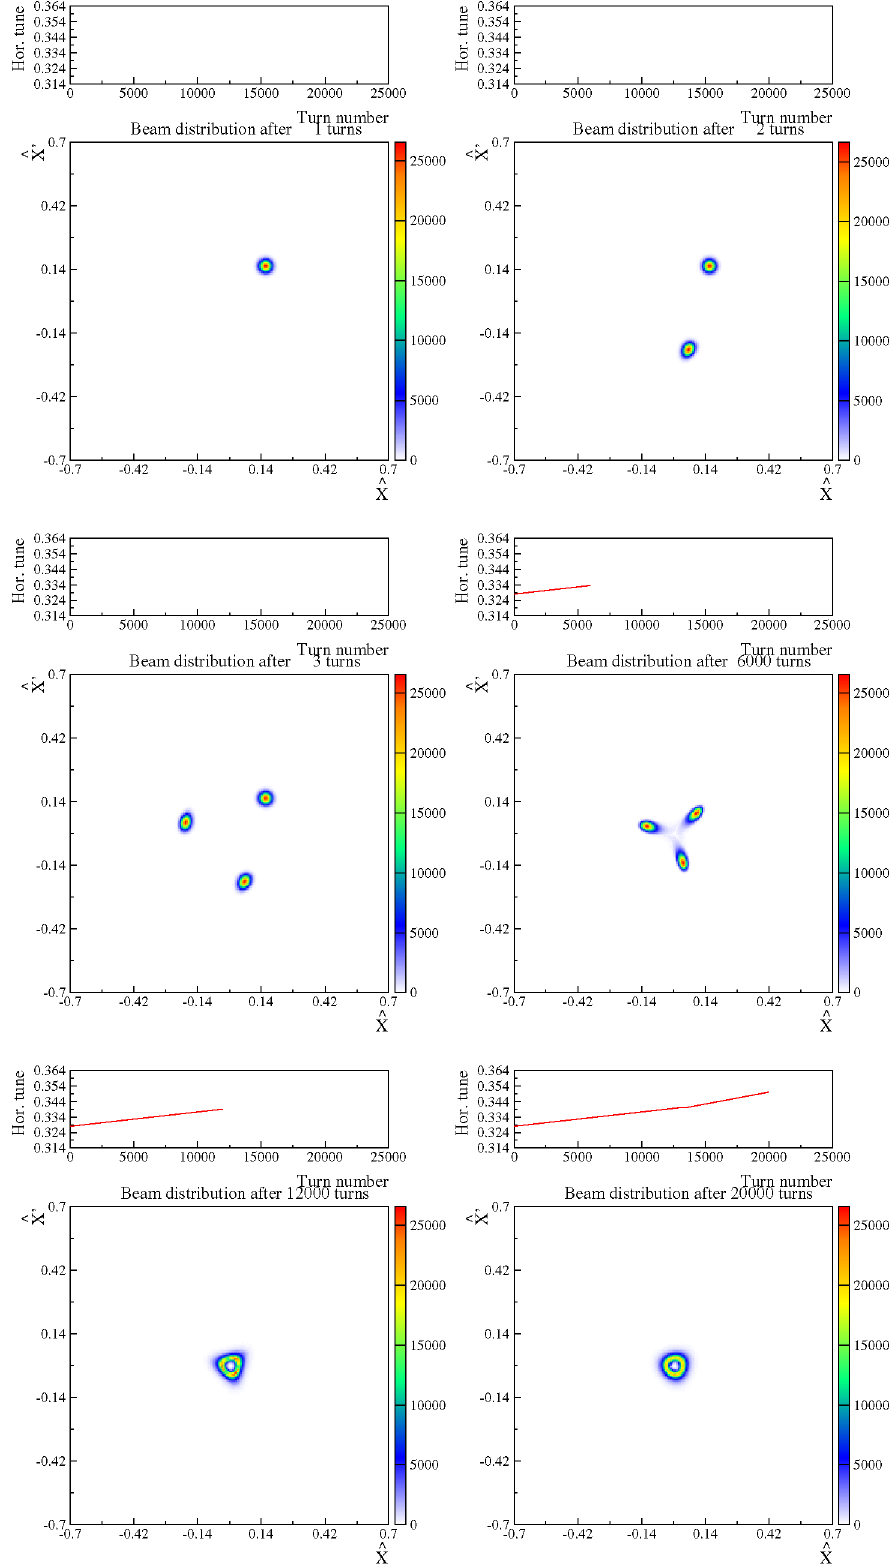
FIG. 4. (Color) Multiturn injection by means of trapping in stable islands of transverse phase space. Three turns are injected and the beamlets merged by crossing the third-order resonance. The tune variation is reported in the upper part of each plot. As for the four- turn injection, a hollow beam in the transverse phase space is